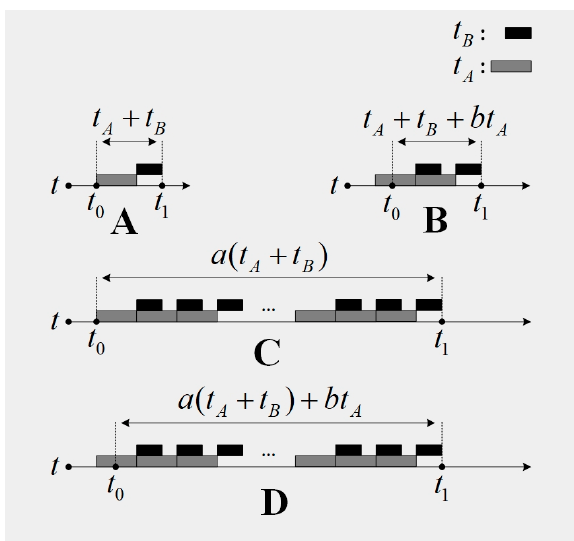
Figure 1. The constitution of the time lag ∆ t . ( A , B ) illustrate the situation that the diagnostic software has enough robustness. ( C , D ) illustrate the situation that the diagnostic software has low robustness.